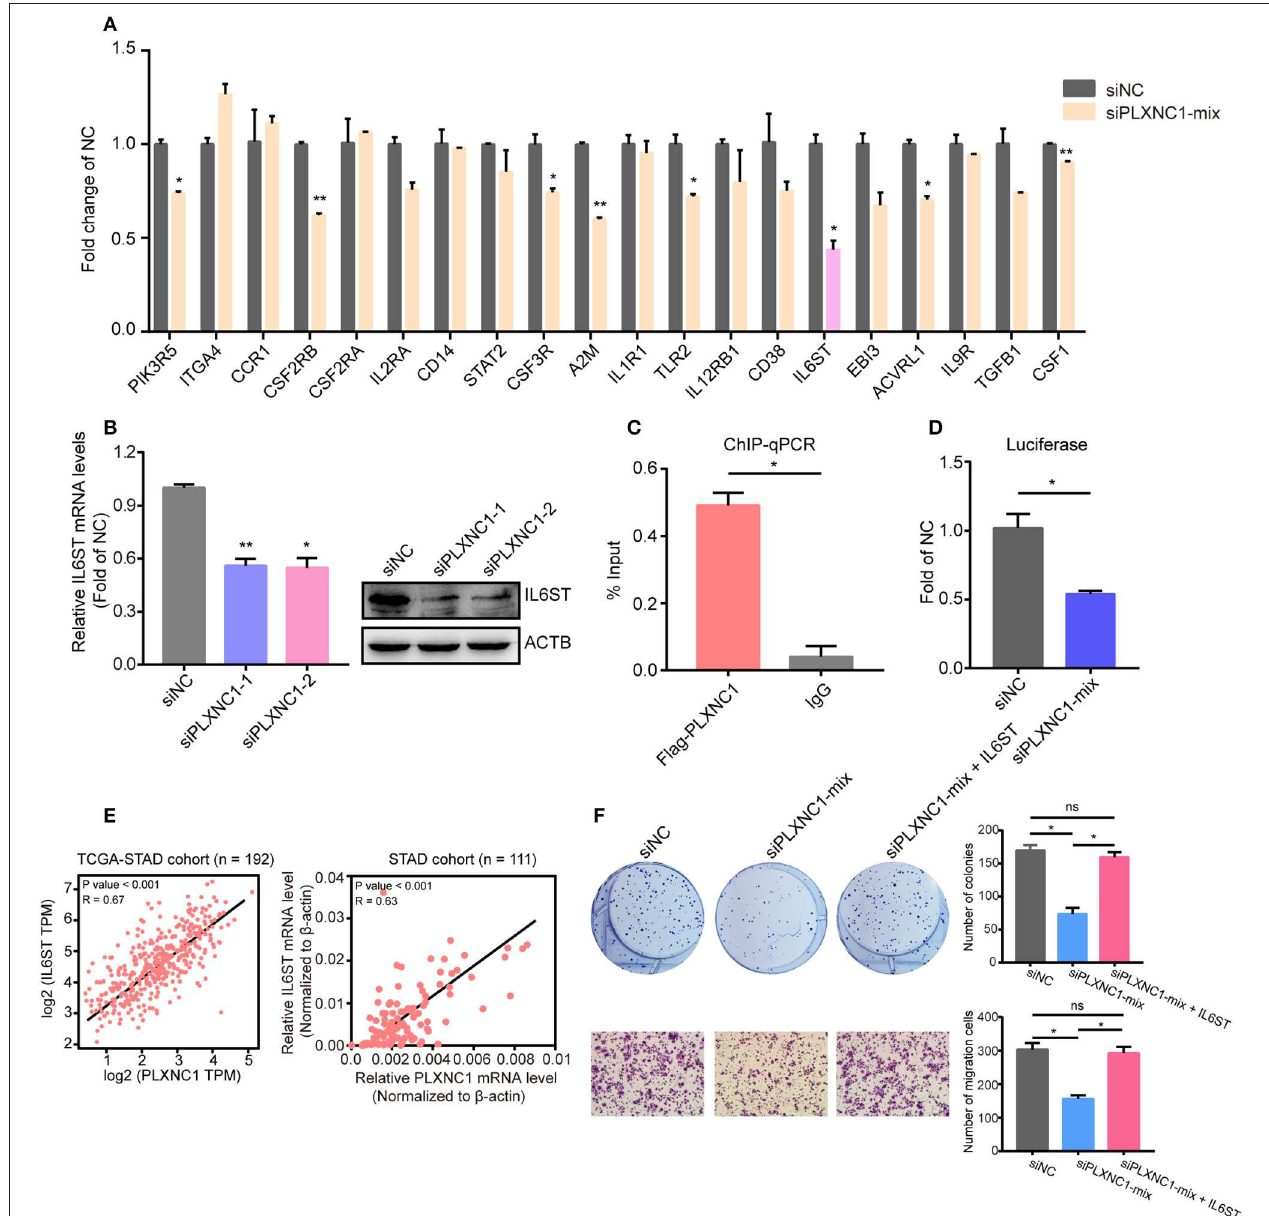
FIGURE 5 | PLXNC1 controls IL6ST expression at the DNA level. (A) The relative mRNA levels of the IL-6/STAT3 pathway genes in AGS cells transfected with PLXNC1-mixed siRNAs and negative control siRNA. (B) IL6ST mRNA levers and protein levels in AGS cells transfected with PLXNC1 siRNAs and negative control. (C) ChIP-qPCR revealed the enrichment of PLXNC1 in IL6ST promoter in AGS cells. (D) The IL6ST promoter activity transfected with PLXNC1-mixed siRNAs and negative control siRNA in AGS cells. (E) Expressional correlation of PLXNC1 and IL6ST in GC tissues. (F) Colony and migration assays of AGS cells transfected with PLXNC1-mixed siRNAs, PLXNC1-mixed siRNAs plus IL6ST overexpression plasmids, or negative control. (A–D,F) Values represent the mean ± SEM, n = 3. * P < 0.05; ** P <